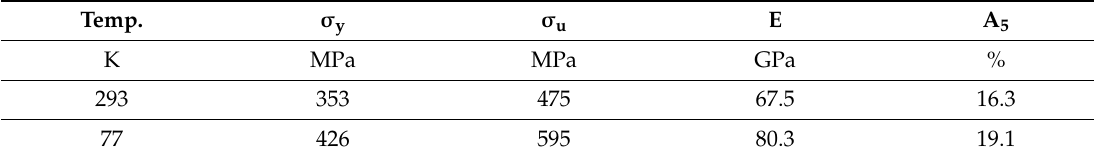
Table 2. Mean values of the mechanical properties of AA2519 aluminum alloy at ambient and cryogenic condition [37].